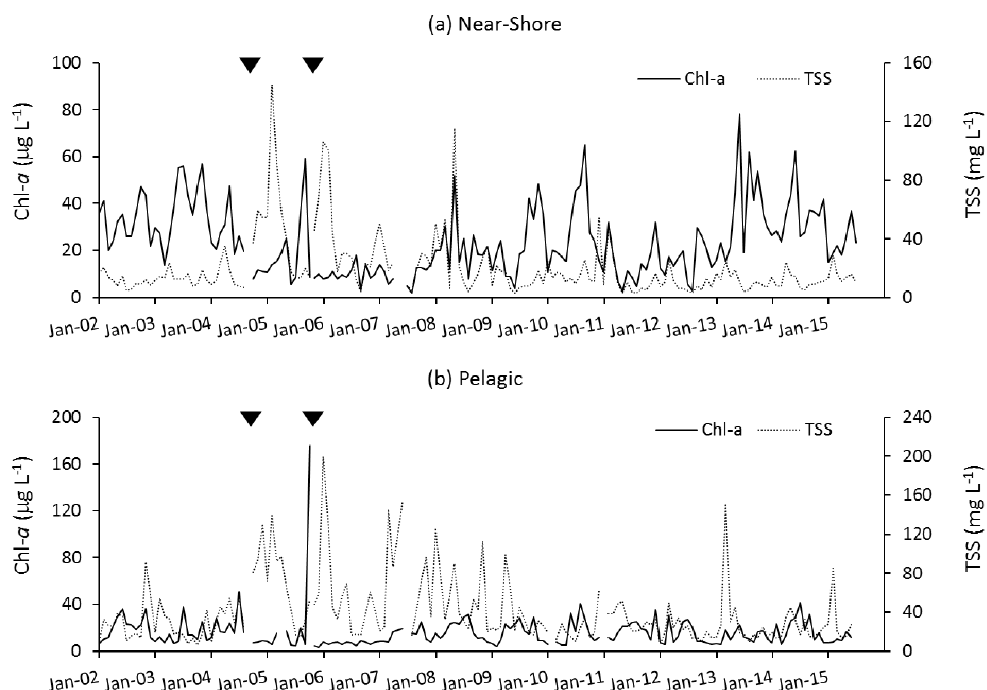
Figure 4. Time series of Chl- a and TSS concentrations in the near-shore and pelagic zones of Lake Okeechobee, in the context of impacts of two hurricanes in 2004 and one hurricane in 2005. The two hurricanes in 2004 were so close together in time that they are represented by a single triangle indicating the timing.